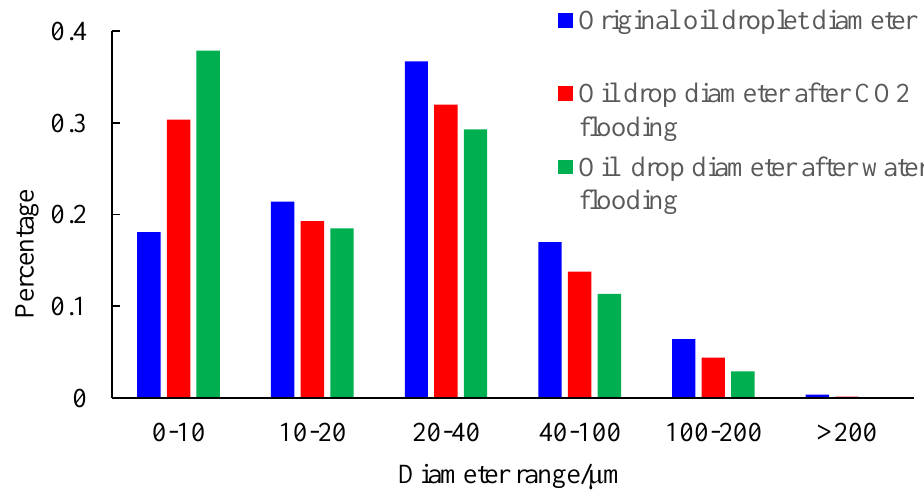
Figure 24. Distribution of the residual oil drop diameter of the Y40 – 92 core.